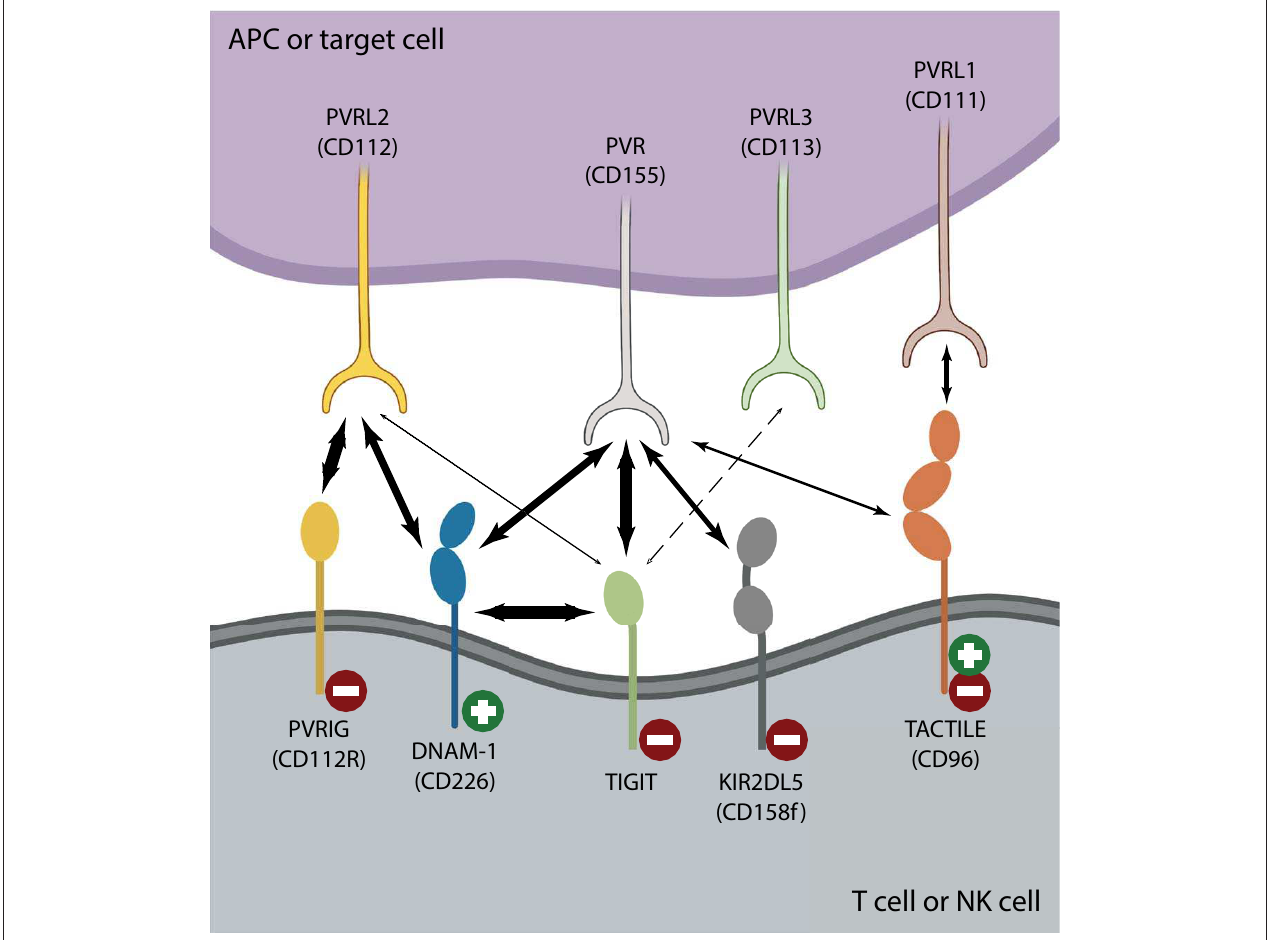
FIGURE 1 | The TIGIT/DNAM-1 immune checkpoint axis. Interactions between inhibiting ( ) and activating ( ) T cell or NK cell receptors belonging to the nectin or nectin-like family of receptors and their corresponding family of ligands are depicted. Strong interactions such as those between TIGIT and PVR or DNAM-1 in cis or PVRIG and PVRL2 are illustrated with heavy arrows. There is no clear consensus regarding whether TIGIT binds PVRL3 (dotted arrow) and it is unclear whether TIGIT/PVRL2 interactions are physiologically relevant in vivo (Stanietsky et al., 2009; Yu et al., 2009; Whelan et al., 2019). DNAM-1 interacts with both PVR and PVRL2 to counter inhibition, yet does so with lower affinity than either TIGIT or PVRIG. TACTILE preferentially interacts with PVRL1 over PVR (Holmes et al., 2019). The affinity of KIR2DL5 for PVR binding is currently unknown, as is whether any other nectin or nectin-like ligand or receptor can serve as its binding